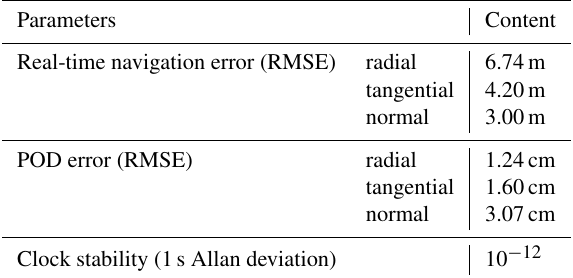
Table 2. The overall FY-3C POD